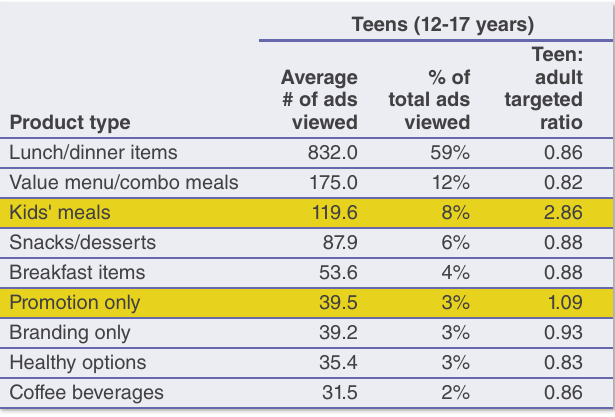
Table 20. Teen exposure to TV advertising by product type and age